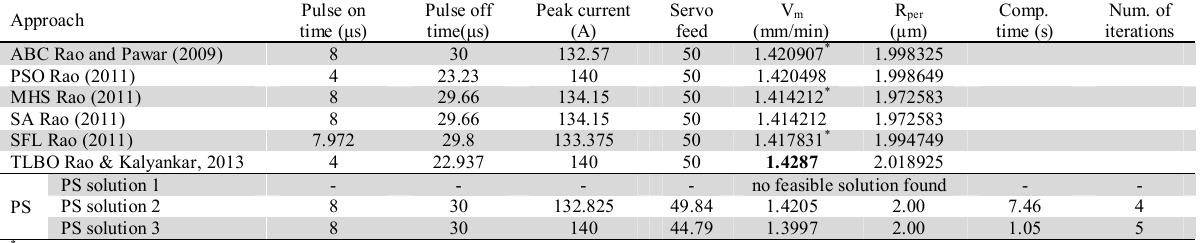
Comparison of optimization solutions for wire electrical discharge machining process